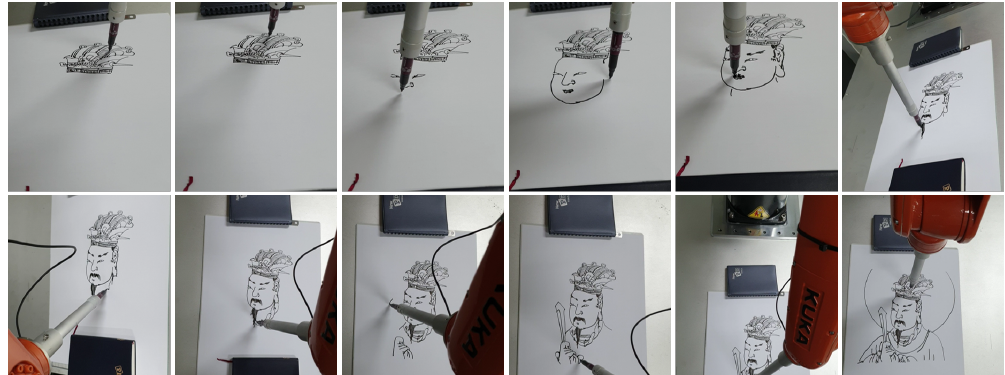
Figure 20. An example of applications utilizing the acquired data: Robot drawing. The robot imitates the expert’s brush movements.